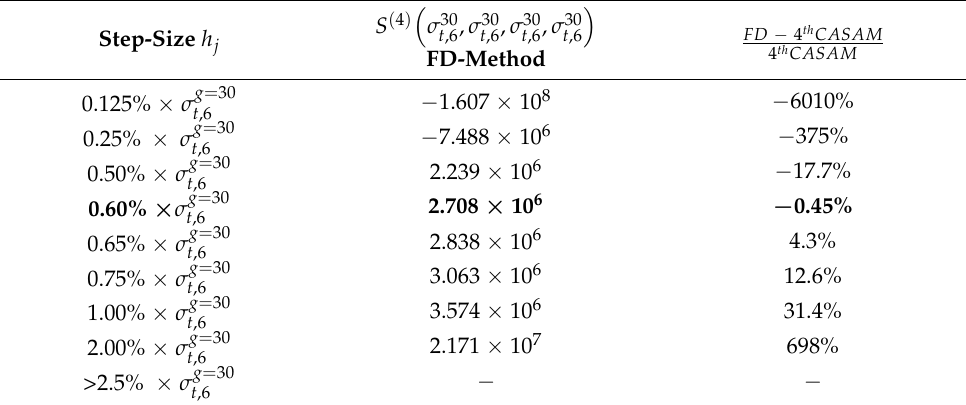
(cid:16) (cid:17) = 30 = 30 = 30 = 30 σ g , σ g , σ g , σ g using Equation (9) with various step-sizes. t ,6 t ,6 t ,6 t ,6